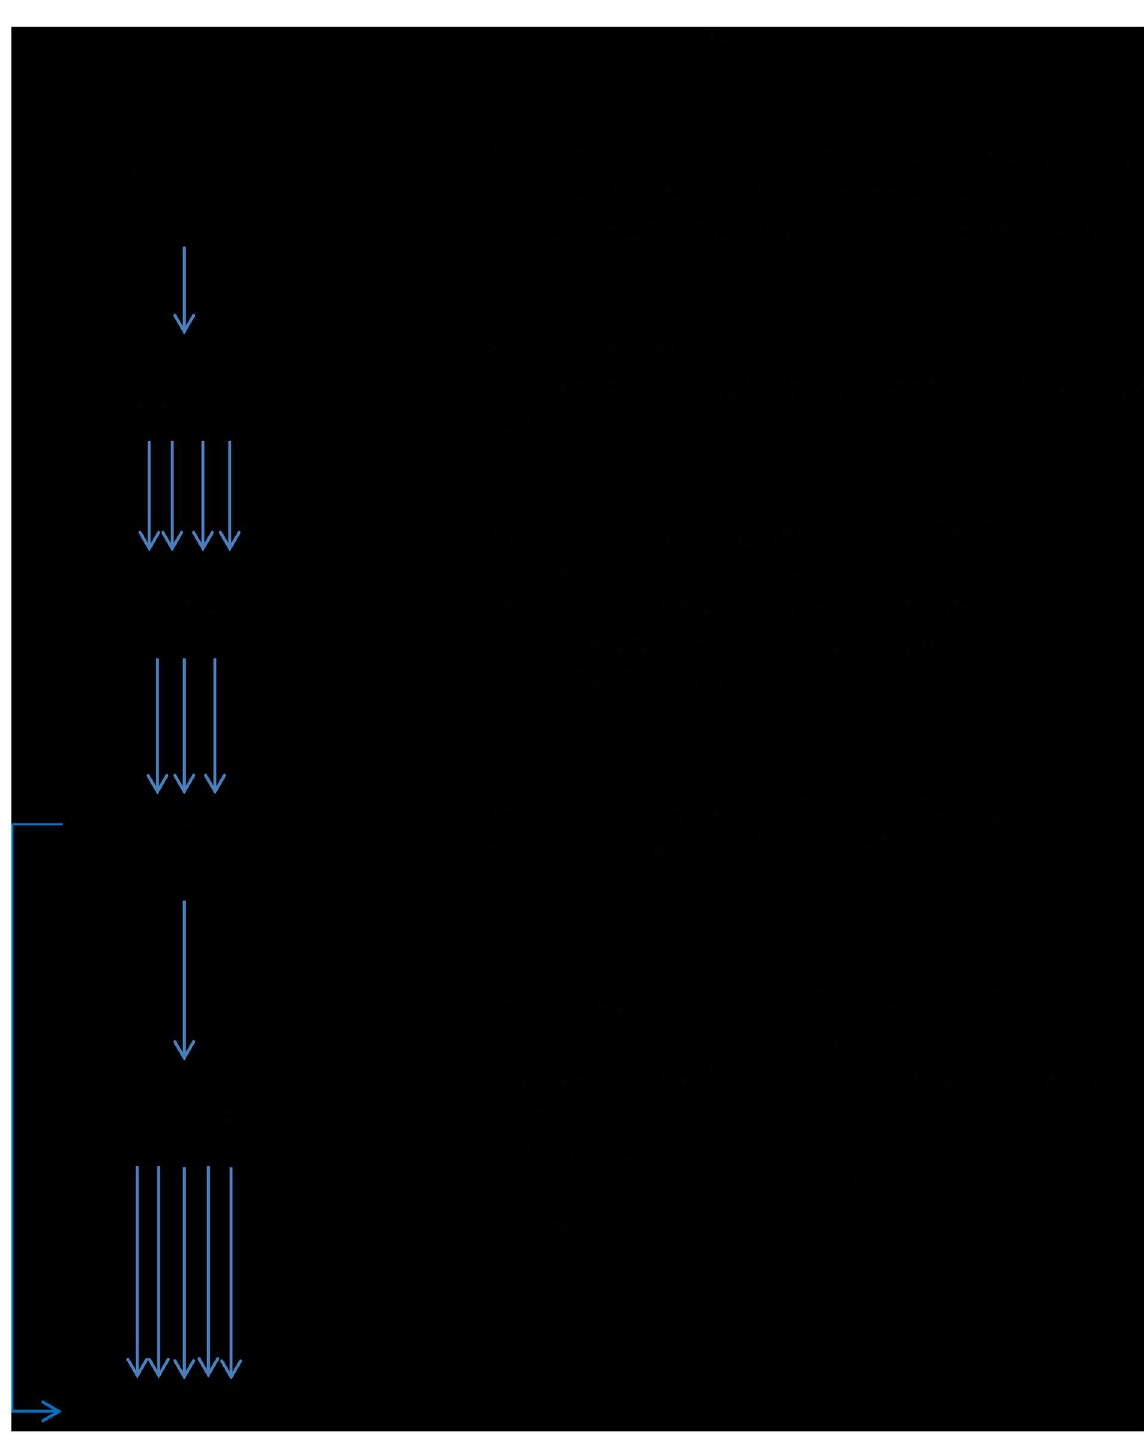
Fig 1. Overviewof the sQMRA model used for the calculations. In- and output (text box with straight corners), processes (roundedcorners) and details (dashedlines) are shown.